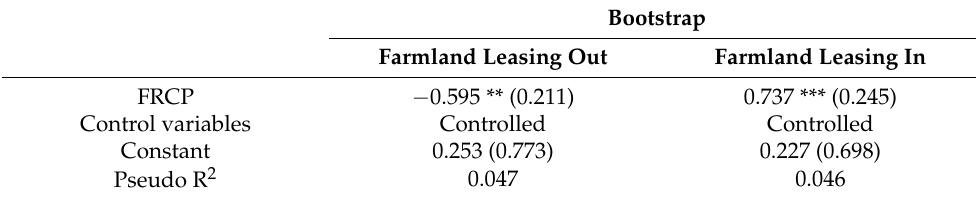
Table 4. Robustness check results of the benchmark model. Bootstrap Farmland Leasing Out Farmland Leasing In